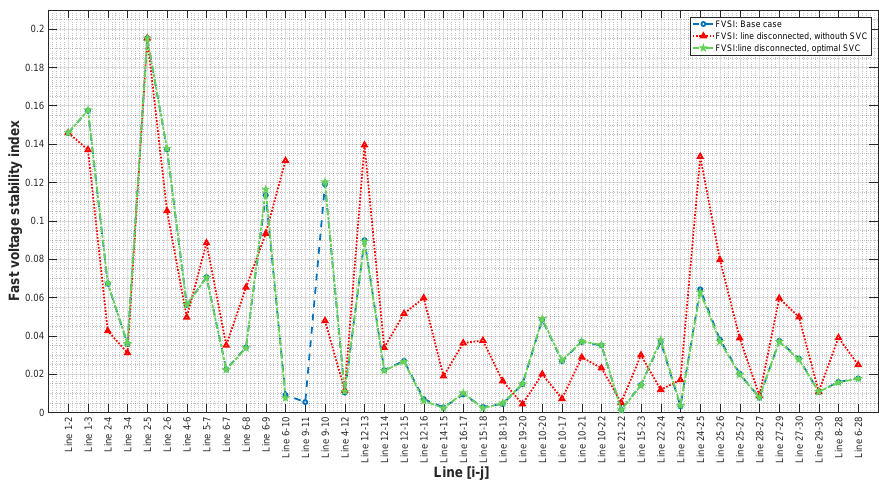
Figure 15. Second study case: FVSIs before/after contingencies and with SVC compensation, when the line that contains the node for the optimal solution is disconnected.